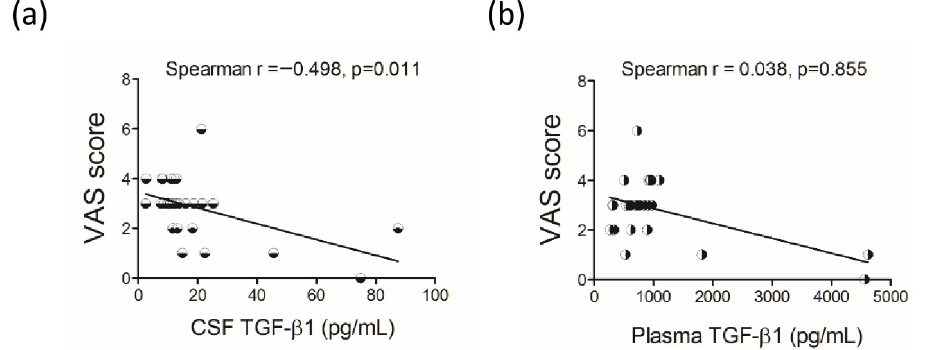
Fig 2. Scatter plot of the Visual Analogue Scale (VAS) scores with the concentration of cerebral spinal fluid (CSF) and plasma TGF- β 1 of patients with OA (n = 29). Spearman correlation analyses with control of age, gender, body mass index and pain drug were used. p < 0.05 represented a significant correlation of variables with the VAS scores.